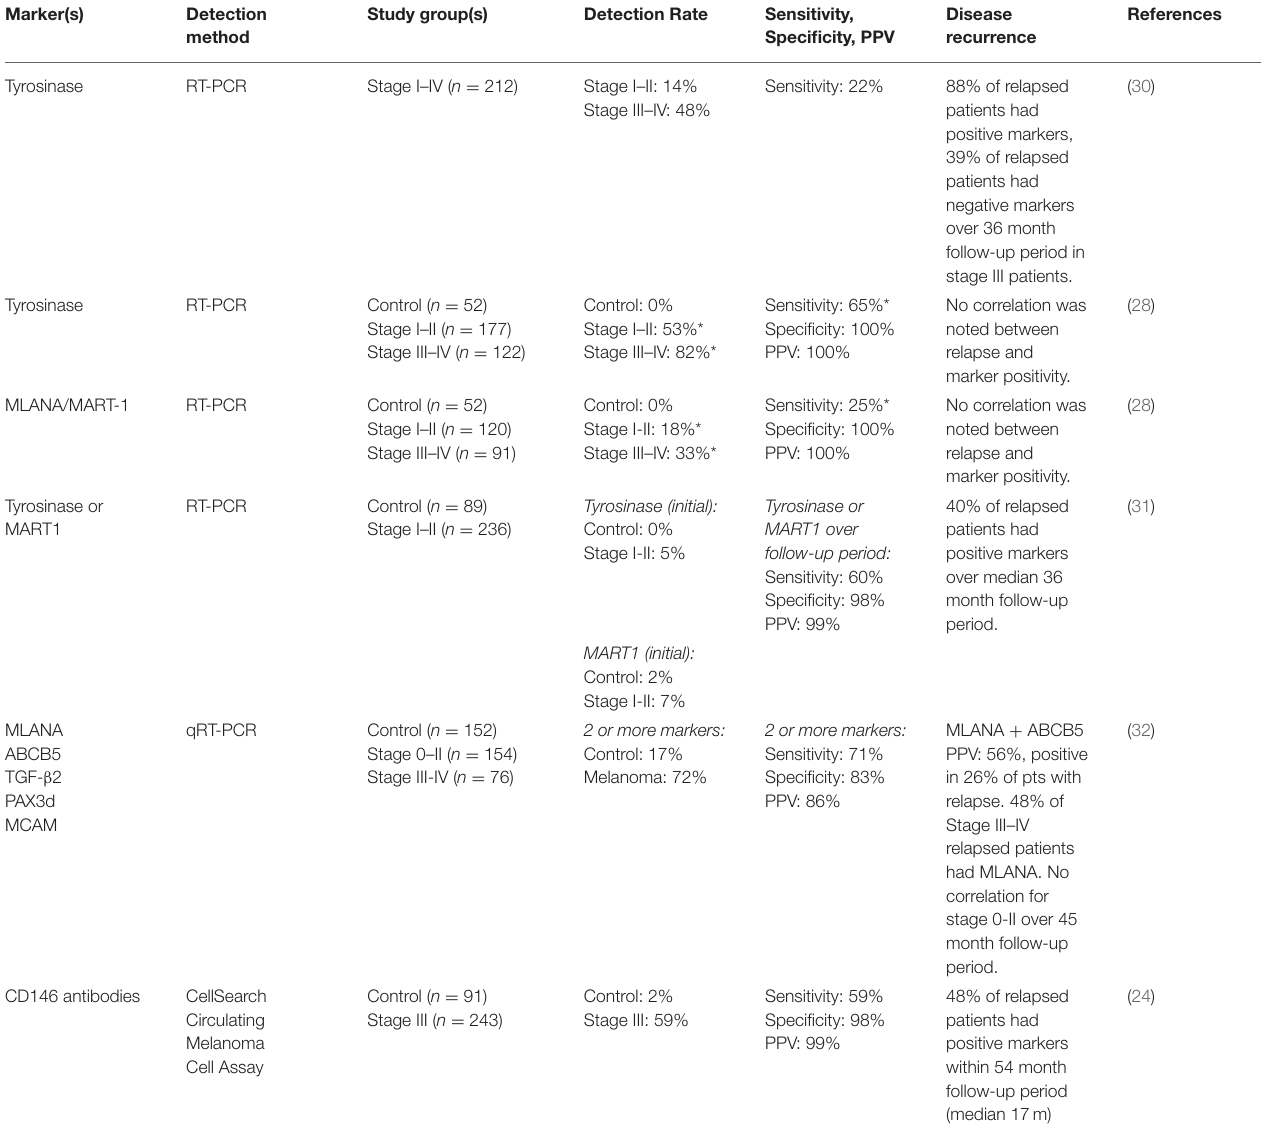
TABLE 1 | CTC markers of melanoma.